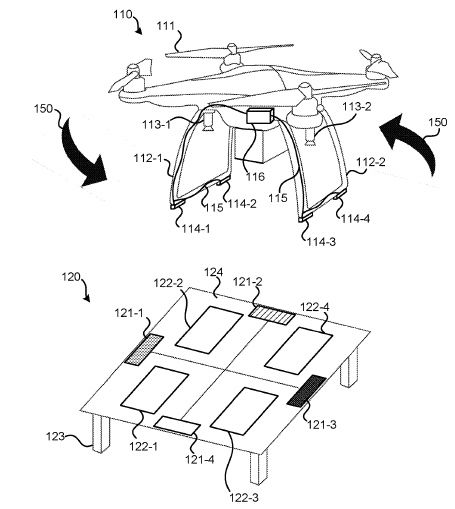
Figure 3. Unmanned aerial vehicle docking system [103] as an example of a landing station without positioning. 110, UAV; 112-1 ... 112-4, UAV legs; 114-1 ... 114-4, electric contacts on UAV legs; 122-1 ... 122-4, electric contacts on the landing site; 124, landing site.